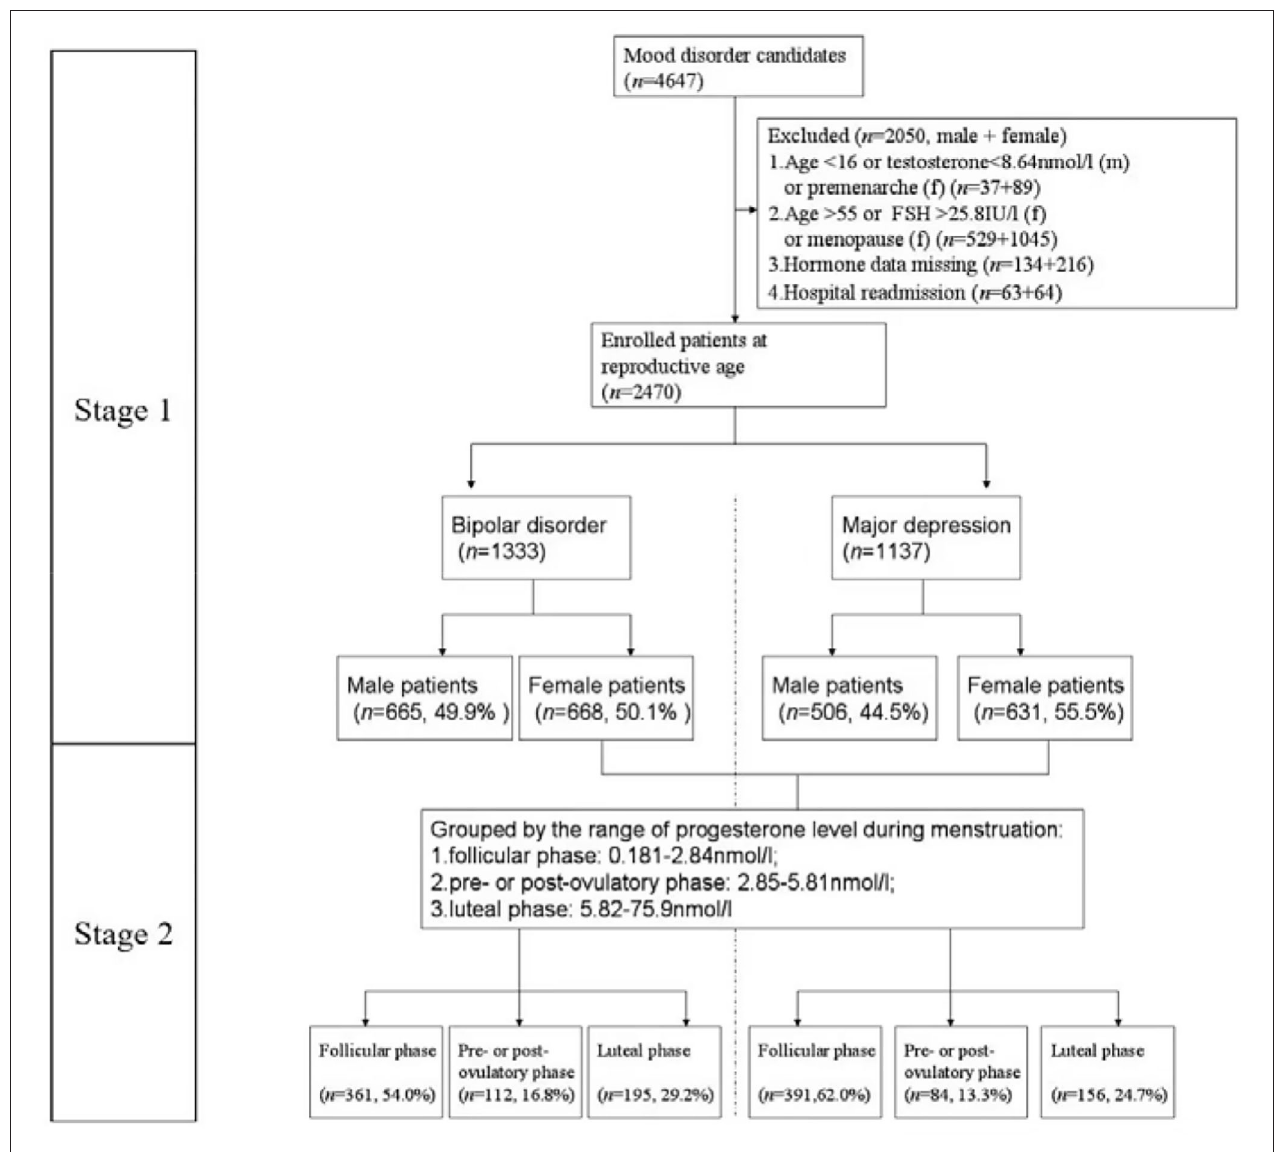
FIGURE 1 | Flowchart of screening process and data